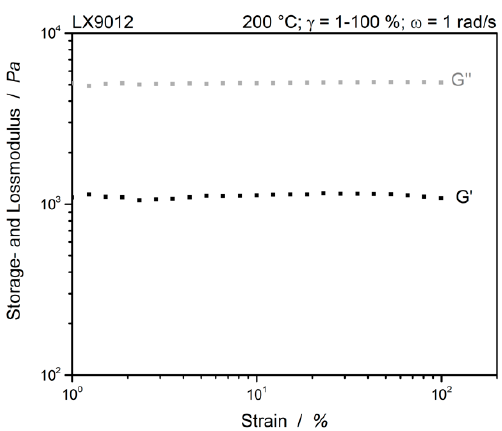
Figure 4. Amplitude sweep of LX9012 without chain extender measured at 200 °C with 1 rad/s.